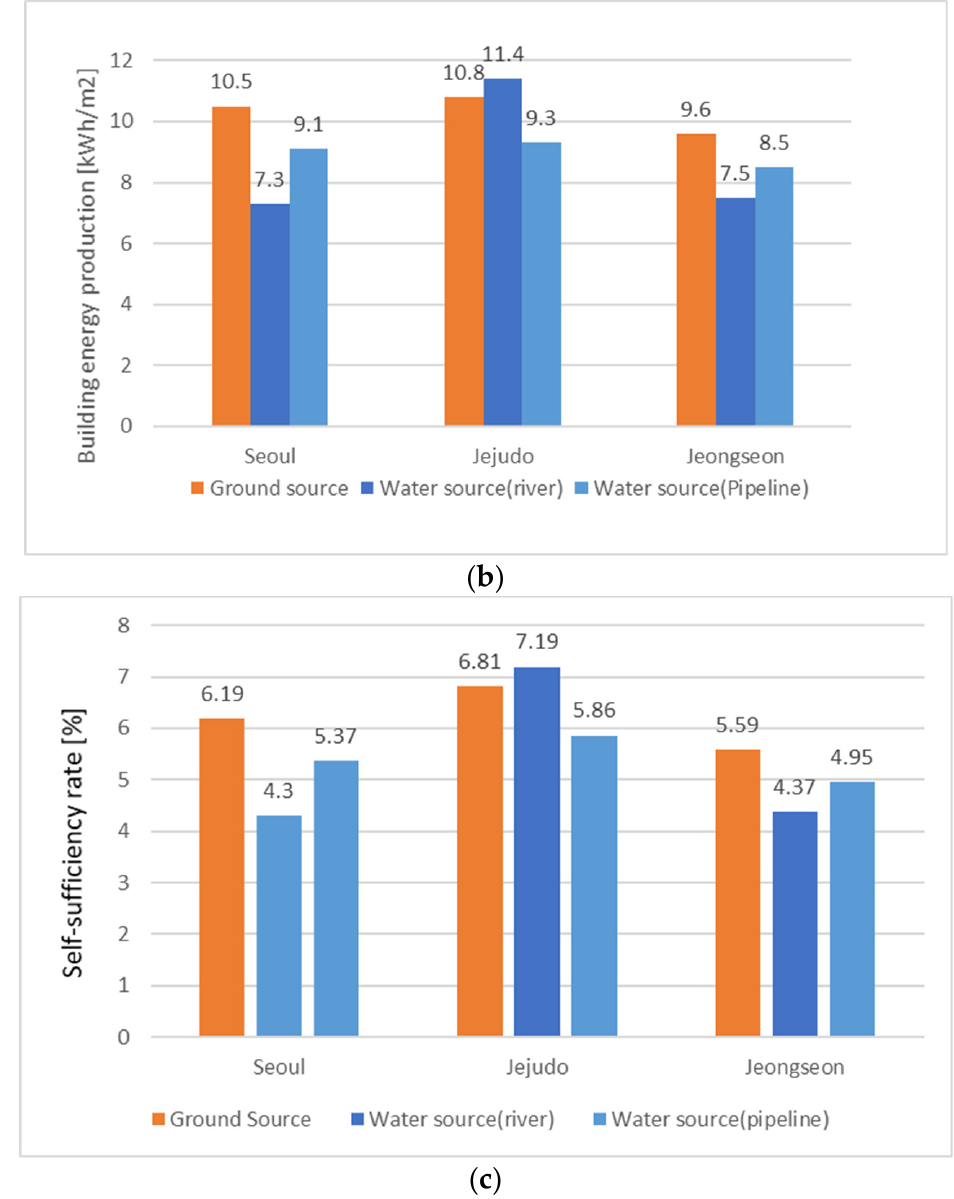
Figure 4. Regional comparison of ground-source heat pumps and water-source heat pumps. Figure 4. ( a – c ) Regional comparison of ground-source heat pumps and water-source heat